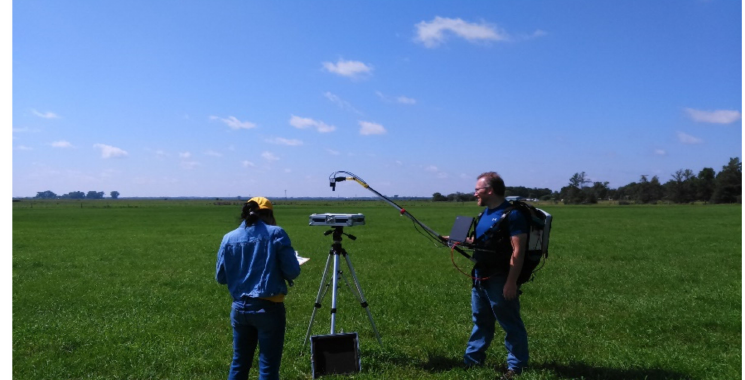
Figure 3. Surface reflectance collection at the South Dakota State University (SDSU) site.